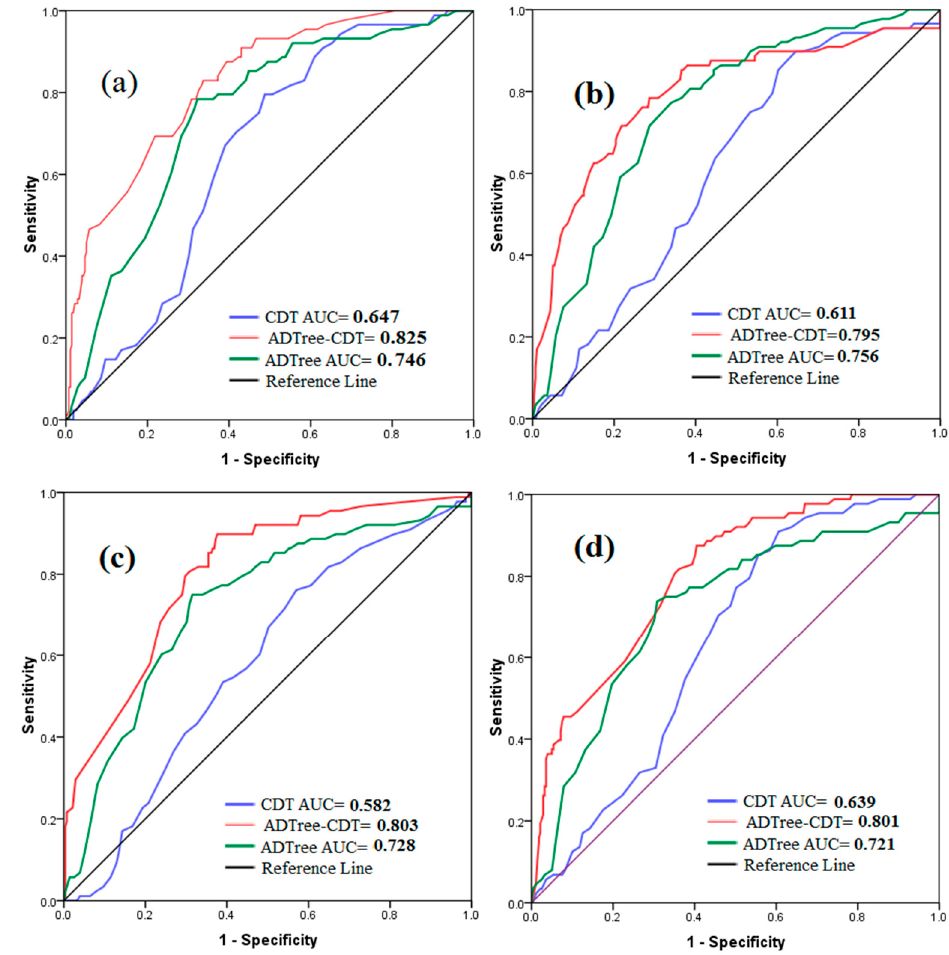
Figure 7. Area under the receiver operation characteristics (ROC) curve ( a ) K1, ( b ) K2, ( c ) K3, ( d ) K4.